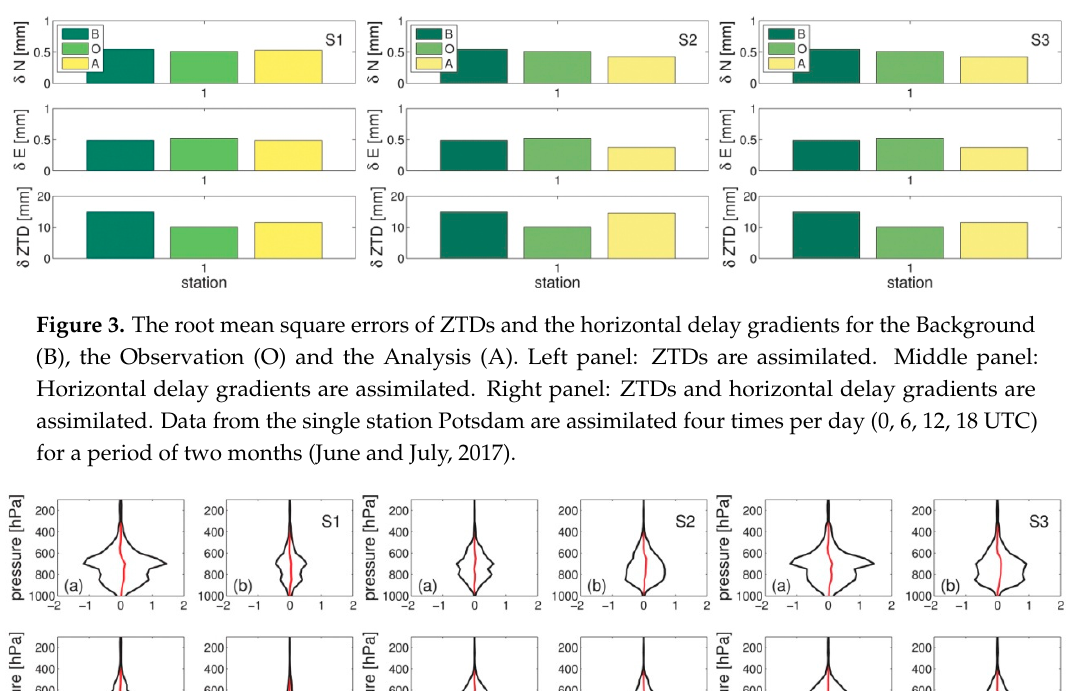
Figure 5. The root mean square error of the background (analysis) refractivity in percent as a function of the pressure in black (red). Left panel: ZTDs are assimilated. Middle panel: horizontal delay gradients are assimilated. Right panel: ZTDs and Horizontal delay gradients are assimilated. In each panel the four plots correspond to the grid points surrounding the station Potsdam. The labels (a), (b), (c) and (d) correspond to the grid points to the north-west, north-east, south-west and south-east respectively. Data from the single station Potsdam are assimilated four times per day (0, 6, 12, 18 UTC) for a period of two months (June and July, 2017).